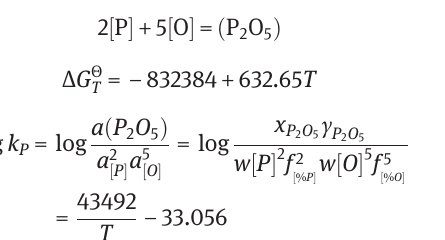
Figure 3: Effect of temperature on dephosphorization ratio.